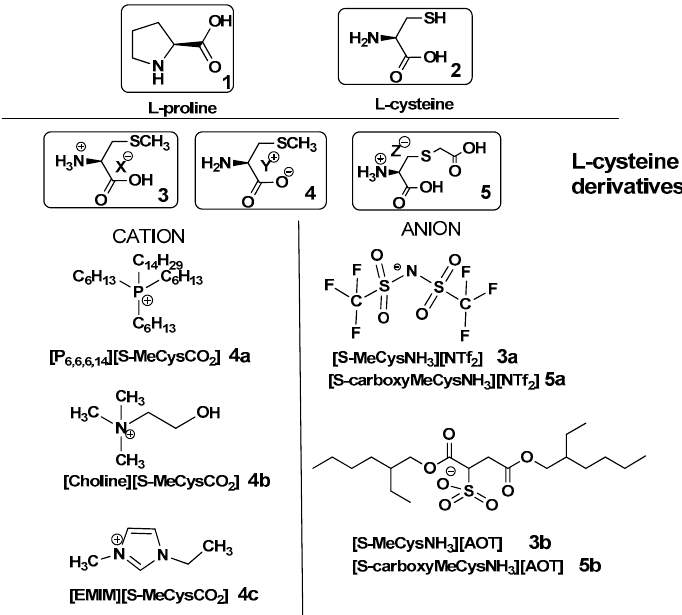
Figure 1. Structures of S-methyl (3 or 4) and S-carboxymethyl L-cysteine (5) derivatives based on chiral ILs comparing with L-proline (1) or L-cysteine (2) as organocatalysts.